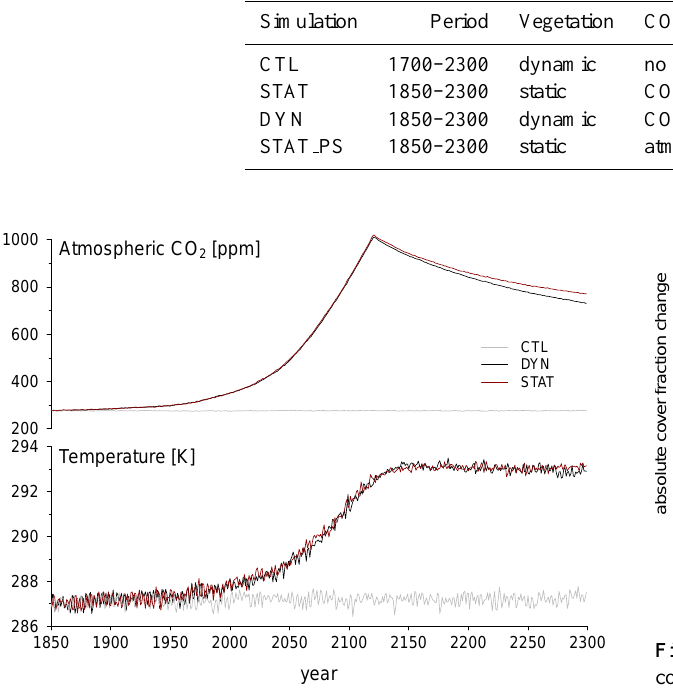
Fig. 2. Time series of annual mean atmospheric CO 2 concentra- tion and global annual mean temperature in the CTL (grey line), the DYN (black line), and the STAT (red line) simulation.